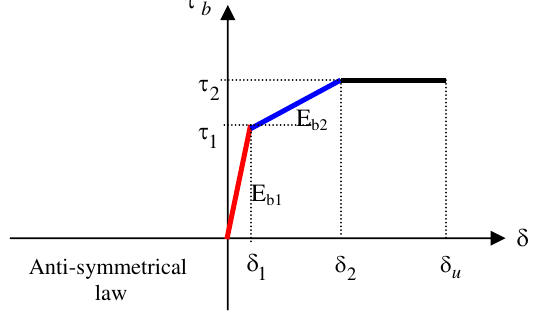
Fig. 2. Local bond stress-slip used To present the effect of flexural bond, two different cases can be distinguished, as: